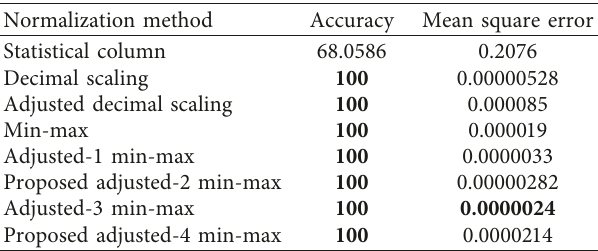
Table 3: Comparative results of prediction efficiency yielded by every tested normalization